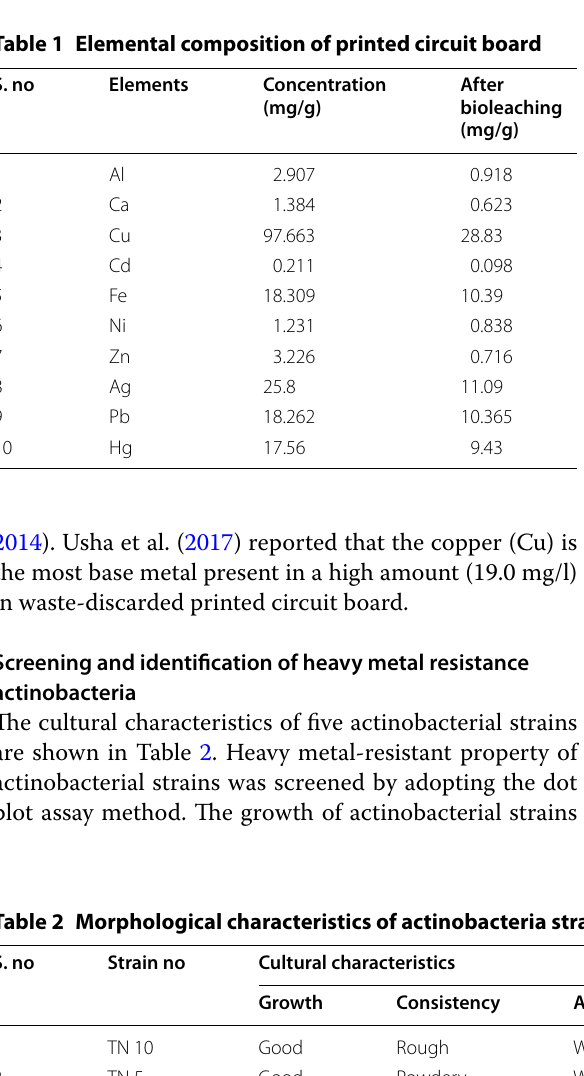
, present; , absent; AMC, aerial mass color; RSP, reverse side pigment; SP, soluble pigment; AM, aerial mycelium; SM, substrate mycelium + −